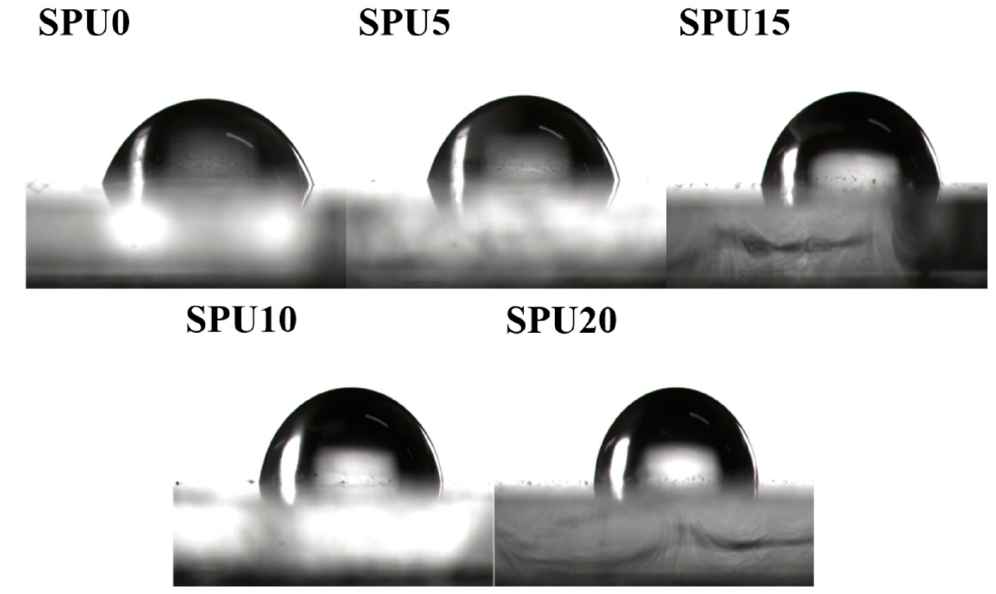
Figure 15. Contacts angle of water on SPU films.